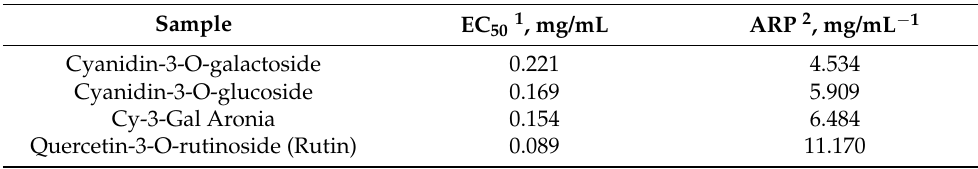
Figure 1. Chemiluminescent intensity attenuation ( A ) (TAR—total antioxidant reactivity) and time ( B ) (TRAP—total reactive antioxidant potential) vs. the concentration of the studied compounds. Values obtained from the quenching of luminol-enhanced chemiluminescence (CL). Table 5. Antioxidant activity by DPPH assay of individual anthocyanins and anthocyanins extracted from A. melanocarpa